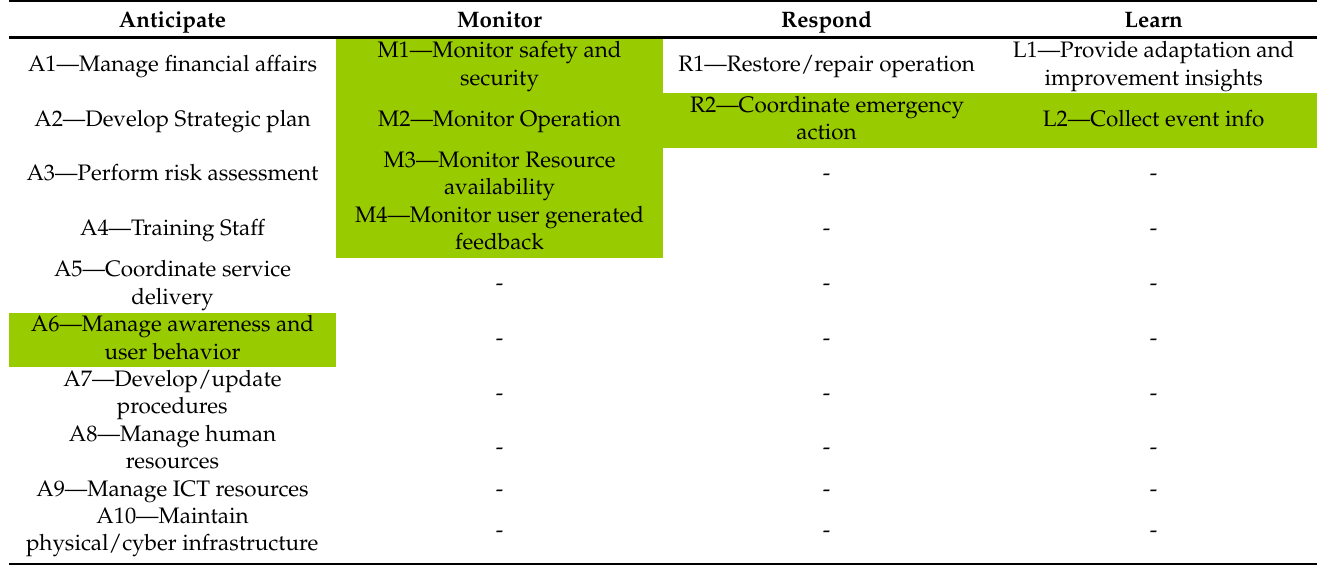
Table 1. FRAM-based UTS